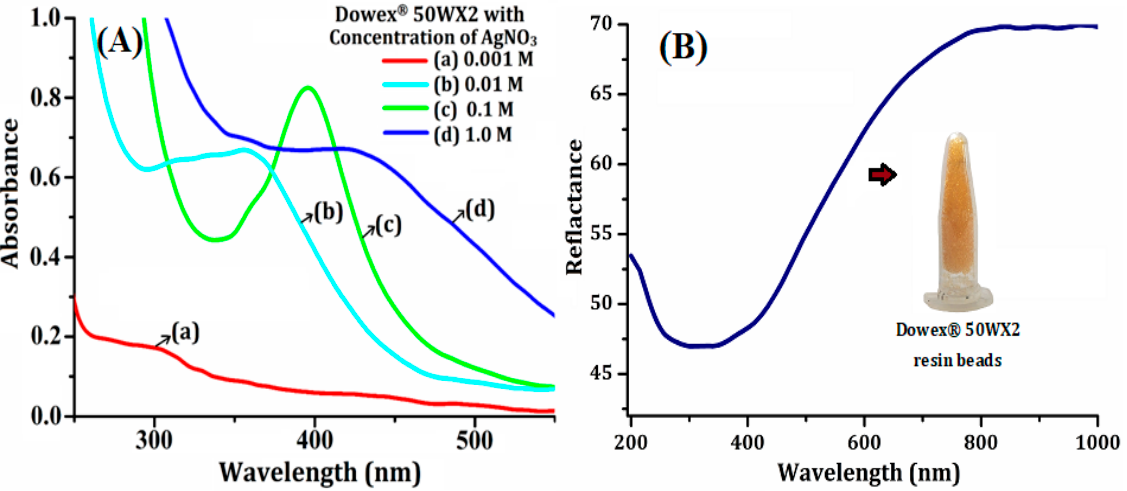
Figure 3. ( A ) UV-Vis absorption spectra of successive formation of CR-AgNCs dispersed in water. Reaction conditions: [Dowex ® 50WX2] = 1 g; [AgNO 3 ] = 1 mM to 1 M; [NaBH 4 ] = 2 mM to 2 M. ( B ) Integrated UV-Vis spectra of Dowex ® 50WX2 resin beads.